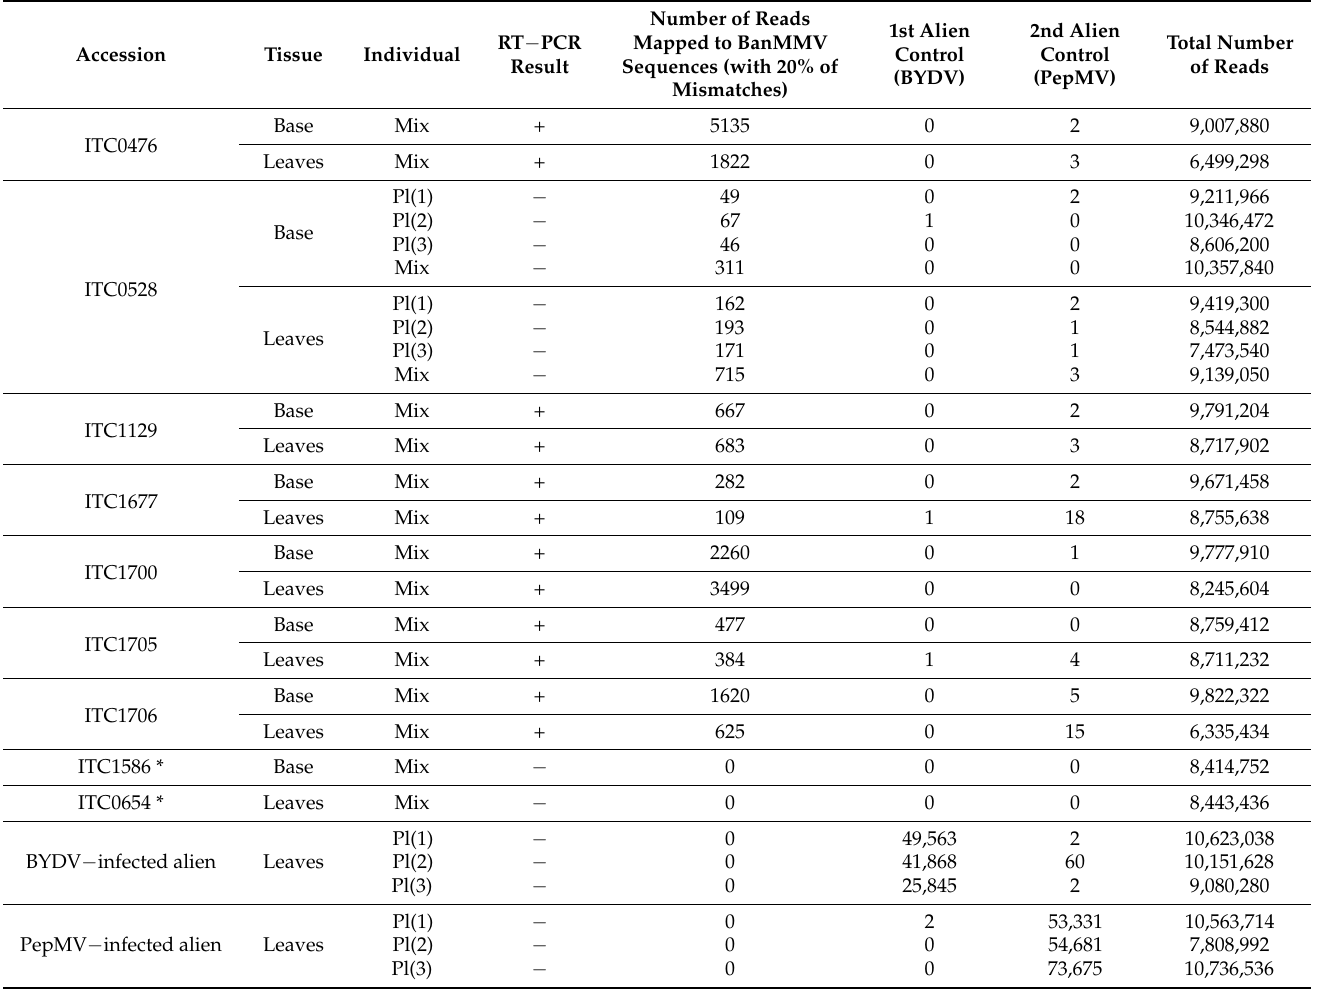
Table 4. HTS results of BanMMV detection from RNA extracts of the base or the leaves of in vitro plants. The number of reads per sample ranged between 6,499,298 and 10,357,840. + and – mean BanMMV detected or not detected respectively